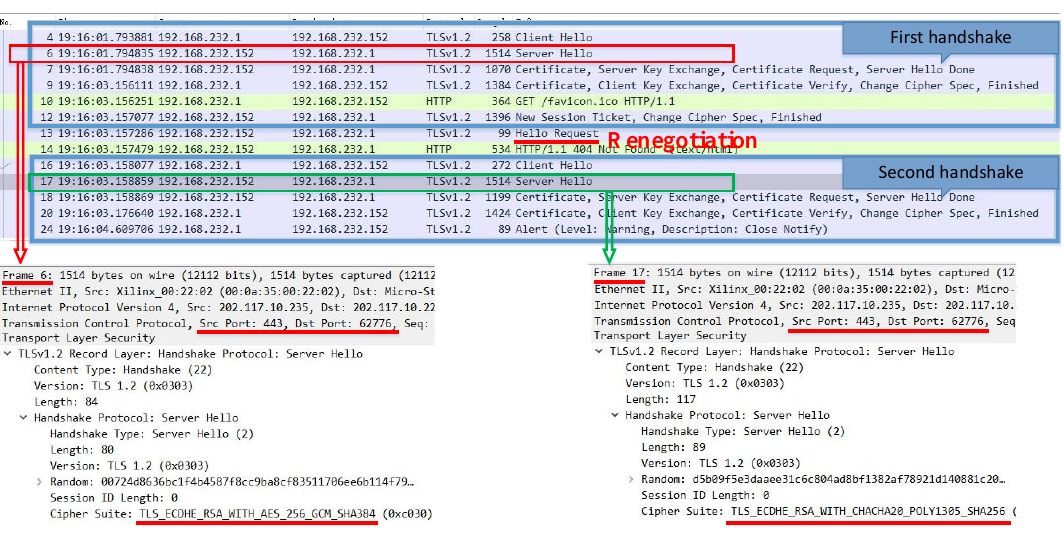
Figure 6. The message exchange procedure of client-aware negotiation based on renegotiation without the highest security strength